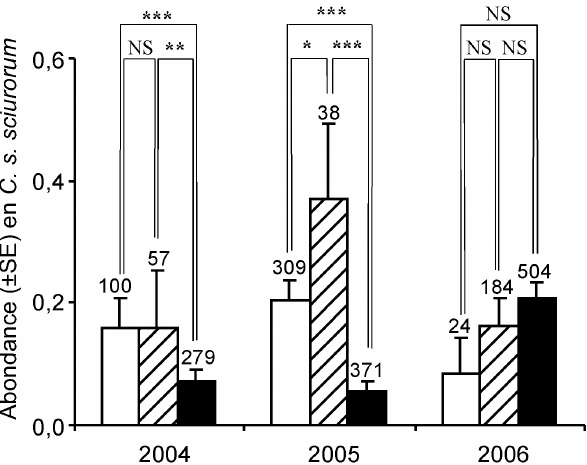
Fig. 4. – Comparaison des abondances moyennes (± 1 SE) en C. s. sciurorum en fonction de l’âge (histogrammes blancs : J1; histo- grammes hachurés : J2; histogrammes noirs : adultes et subadultes) et de l’année chez les tamias capturés entre 2004 et 2006 en Forêt de Sénart. La taille des échantillons est indiquée au-dessus des his- togrammes, ainsi que les différences entre les moyennes (NS : non significative; * p < 0,05; ** p < 0,01; *** p < 0,001).